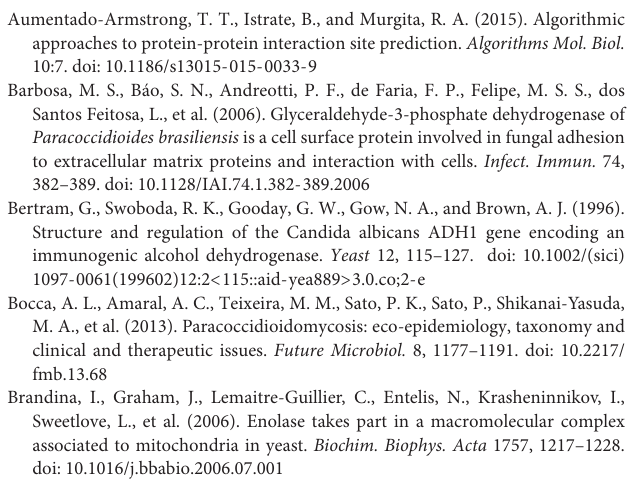
FIGURE S1 | Molecular Dynamics result evaluation. Ramachandran plots showing the analysis of residues in allowed, favored and forbidden regions (A) before and (B) after GAPDH molecular dynamics. The light blue regions are favorable and the dark blue regions are allowed. Regions outside blue lines are forbidden regions and may characterize unconserved regions of GAPDH. (C) RMSD trajectories over 100 ns of GAPDH MD simulation. (D) The cluster plot shows seven sets of conformations along the GAPDH MD trajectories and the first cluster shows the most stable conformation. FIGURE S2 | Schematic representation of GAPDH interaction with 18 protein partners. Each image shows two conformations of GAPDH (gray), its protein partner (different colors) and the interacting interface (dark-blue). (A) malate dehydrogenase; (B) succinate dehydrogenase; (C) triosephosphate